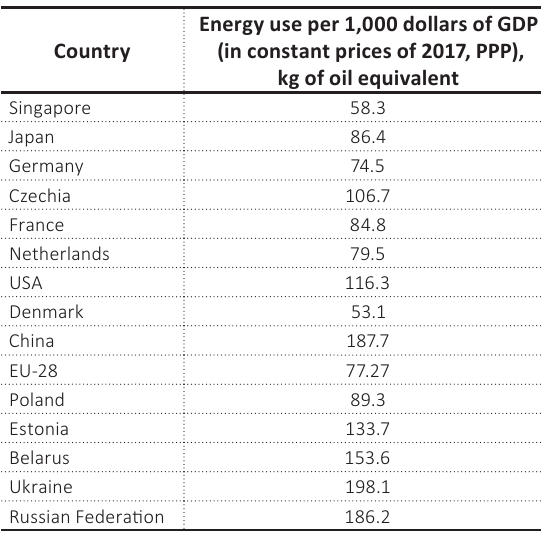
Table 2. Level of energy efficiency in Ukraine and other